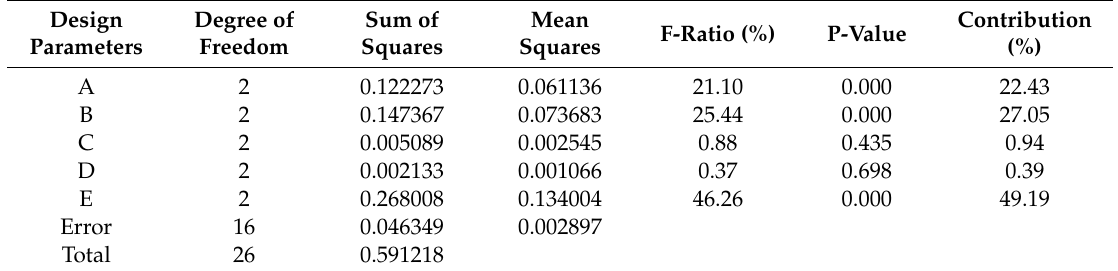
Table 7. Analysis of variance for shrinkage in the transverse direction.